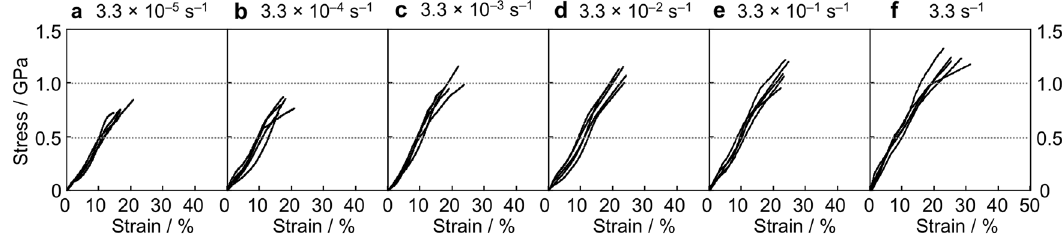
Fig. 1 Effects of strain rates on stress-strain curves of spider dragline silk fi bers. Stress – strain curves of spider dragline silk fi bers at RH43% under different strain rates: a 3.3 × 10 − 5 s − 1 , b 3.3 × 10 − 4 s − 1 , c 3.3 × 10 − 3 s − 1 , d 3.3 × 10 − 2 s − 1 , e 3.3 × 10 − 1 s − 1 , and f 3.3 s − 1